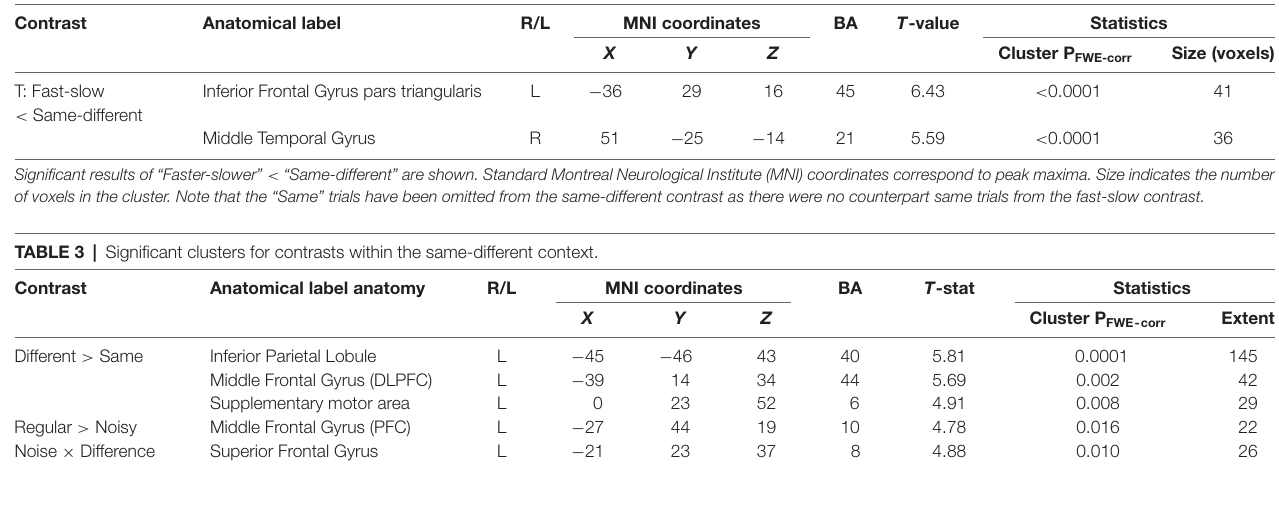
TABLE 2 | Significant clusters for the effect of context (fast-slow vs. same-different).